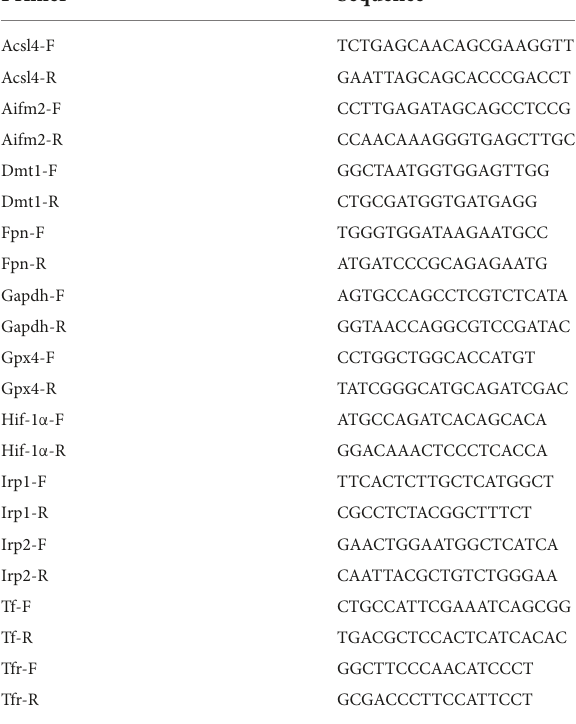
TABLE 1 PCR primers